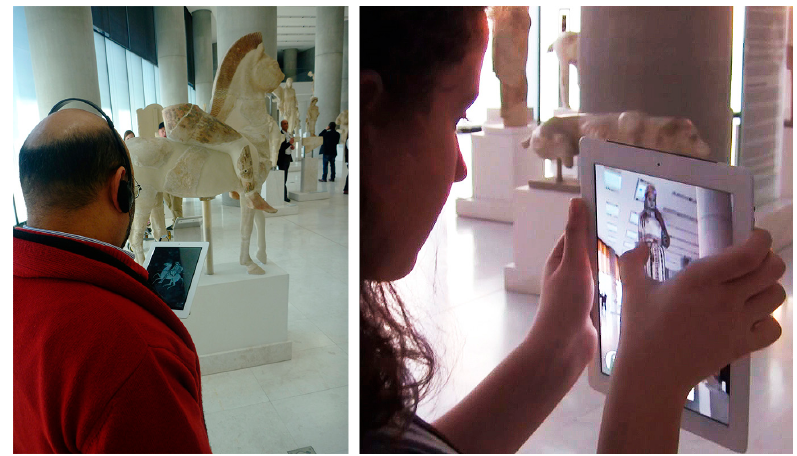
Figure 1. Visitors handle a tablet and don headphones to experience and interact with a personalized story at the Acropolis Museum (AM).